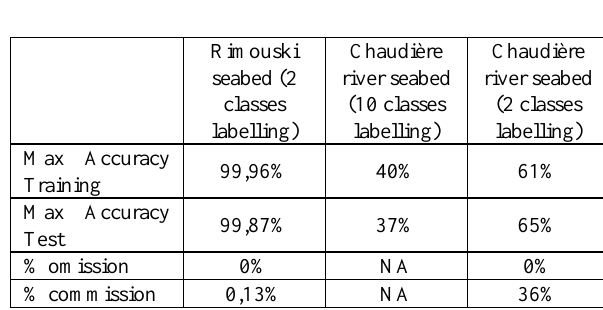
Table 1. Percentage of points in the two main classes of the data sets used in the experiments